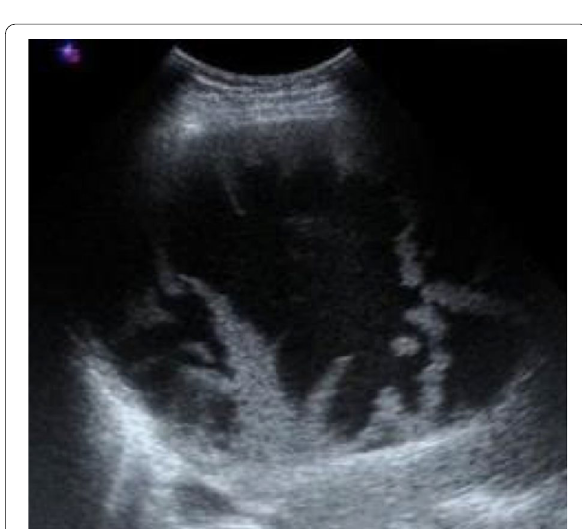
Fig. 5 Subacute haemorrhage in a simple hepatic cyst in a 70-year-old male. Ultrasonography shows a spontaneous mobile area of hyperechogenicity inside the cyst, appearing as a “fern